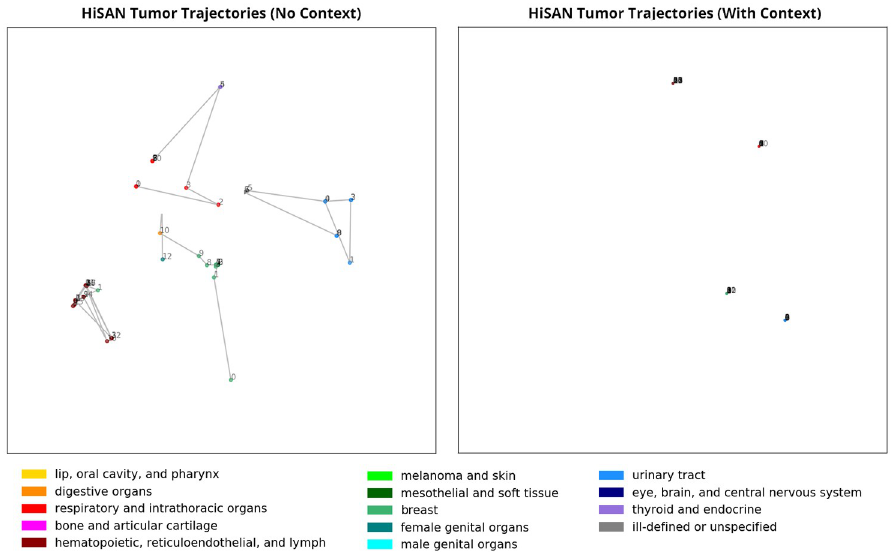
Fig 3. The cancer site document embeddings generated by the HiSAN for the pathology reports associated with four unique tumor IDs, with and without the self-attention module for capturing case-level context. These figures share the same axes as Fig 2 and thus can be directly compared. Within each of the four trajectories, document embeddings are numbered from earliest to latest and are colored by the predicted organ system. We notice that without case-level context, reports belonging to the same tumor ID are classified under different organ systems. Adding case-level context addresses this problem and all document embeddings from the same tumor ID are placed in the same location in the embedding